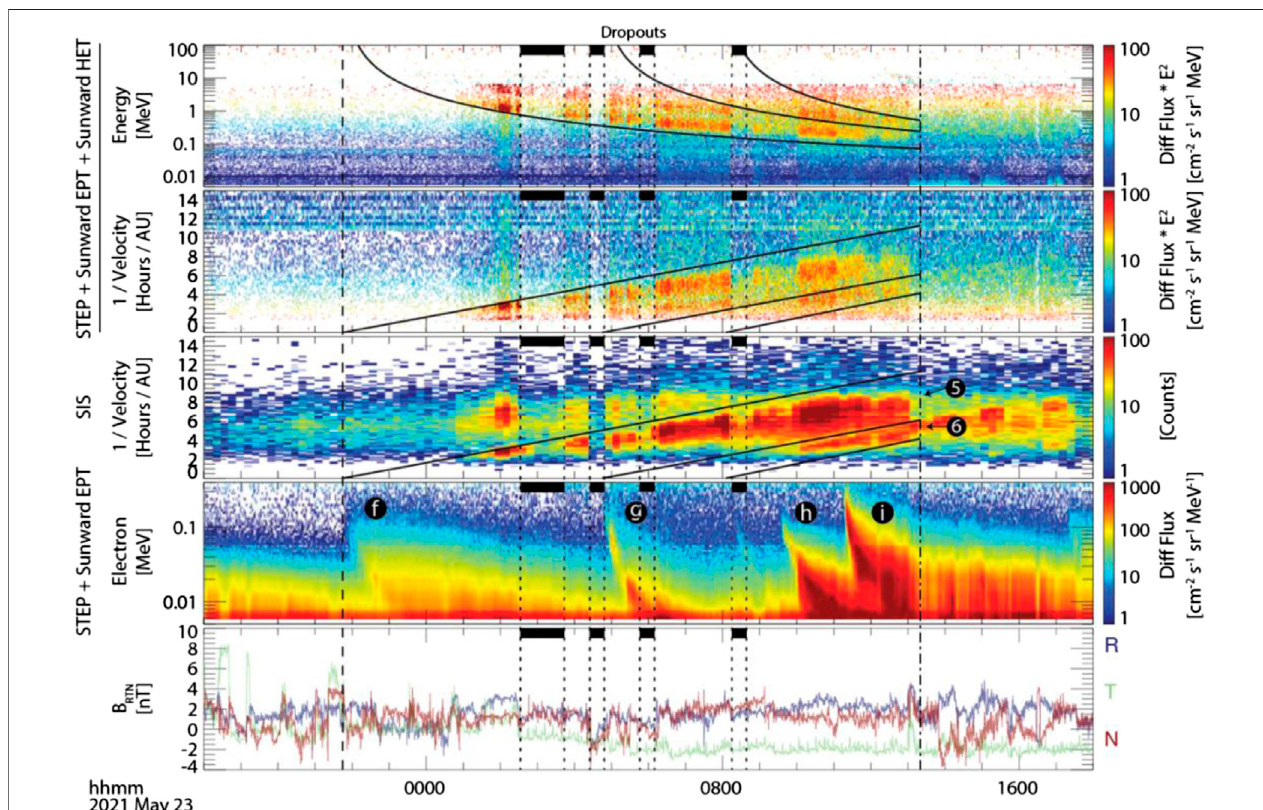
FIGURE 4 | Same format as Figure 3 but for events #5-6 in Figure 1